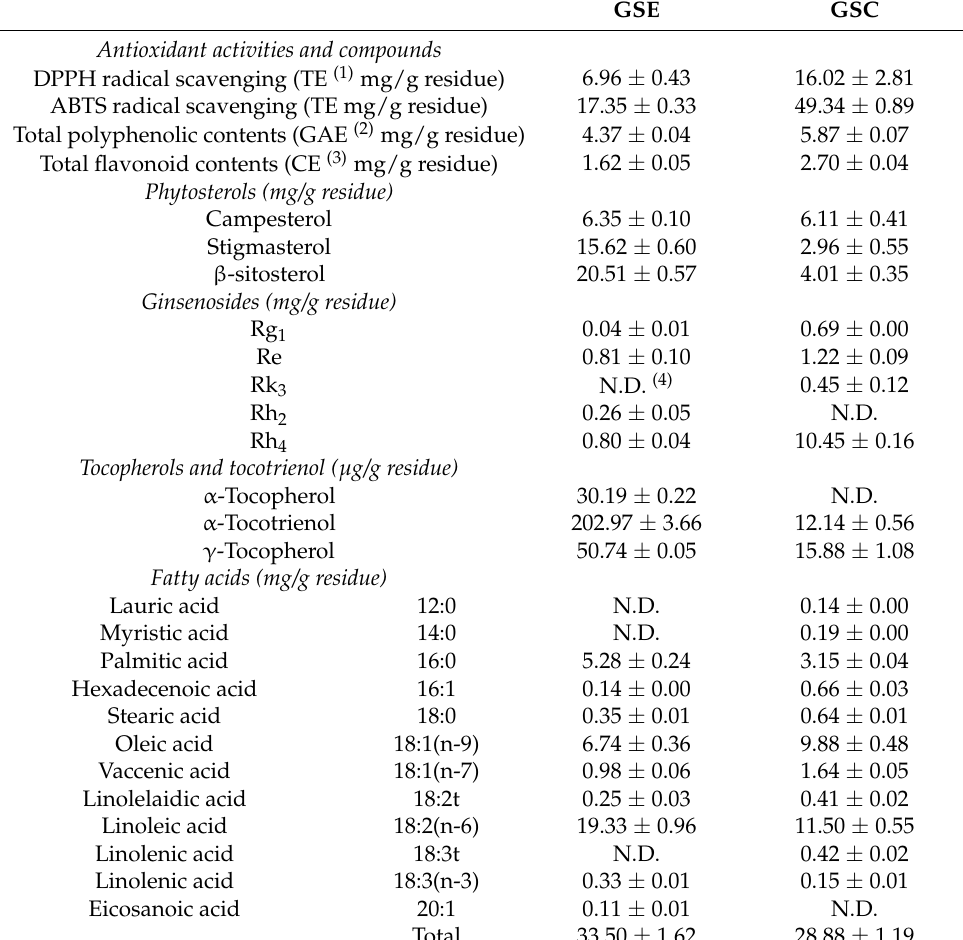
Table 1. Antioxidant activities and phytochemical contents in ginseng seeds.